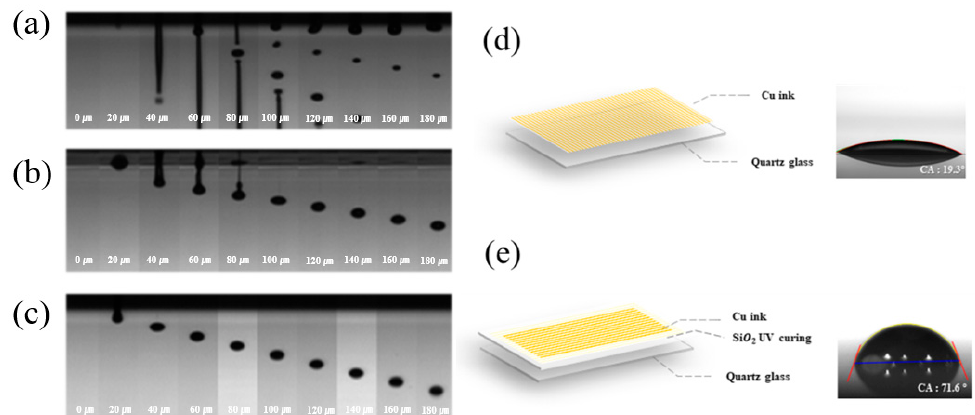
Figure 7. Jetting behavior of IPL-sinterable nano Cu ink; ( a ) before optimization; ( b ) after single-pulse optimization; ( c ) after multi-pulse optimization, contact angle, and ink-jet printed pattern of IPL-sinterable nano Cu ink; ( d ) on a quartz glass substrate; and ( e ) on photo-cured SiO 2 insulation layer.